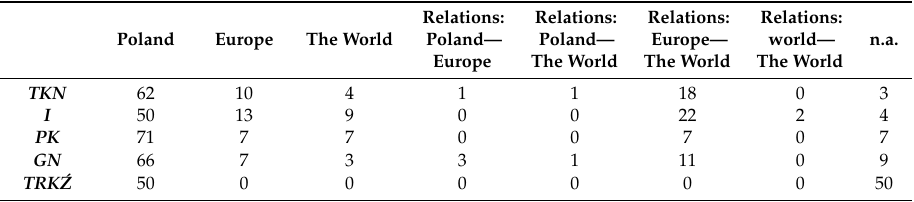
Table 10. Post topics—geographical aspect